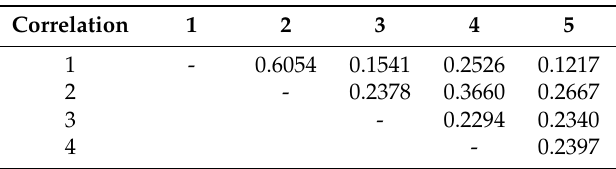
Table 5. Correlation